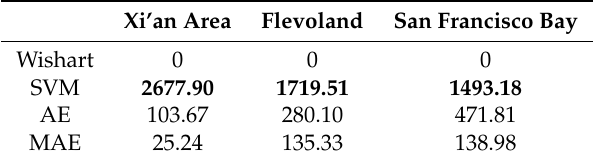
Table 11. Training time of three PolSAR images with different methods (s).